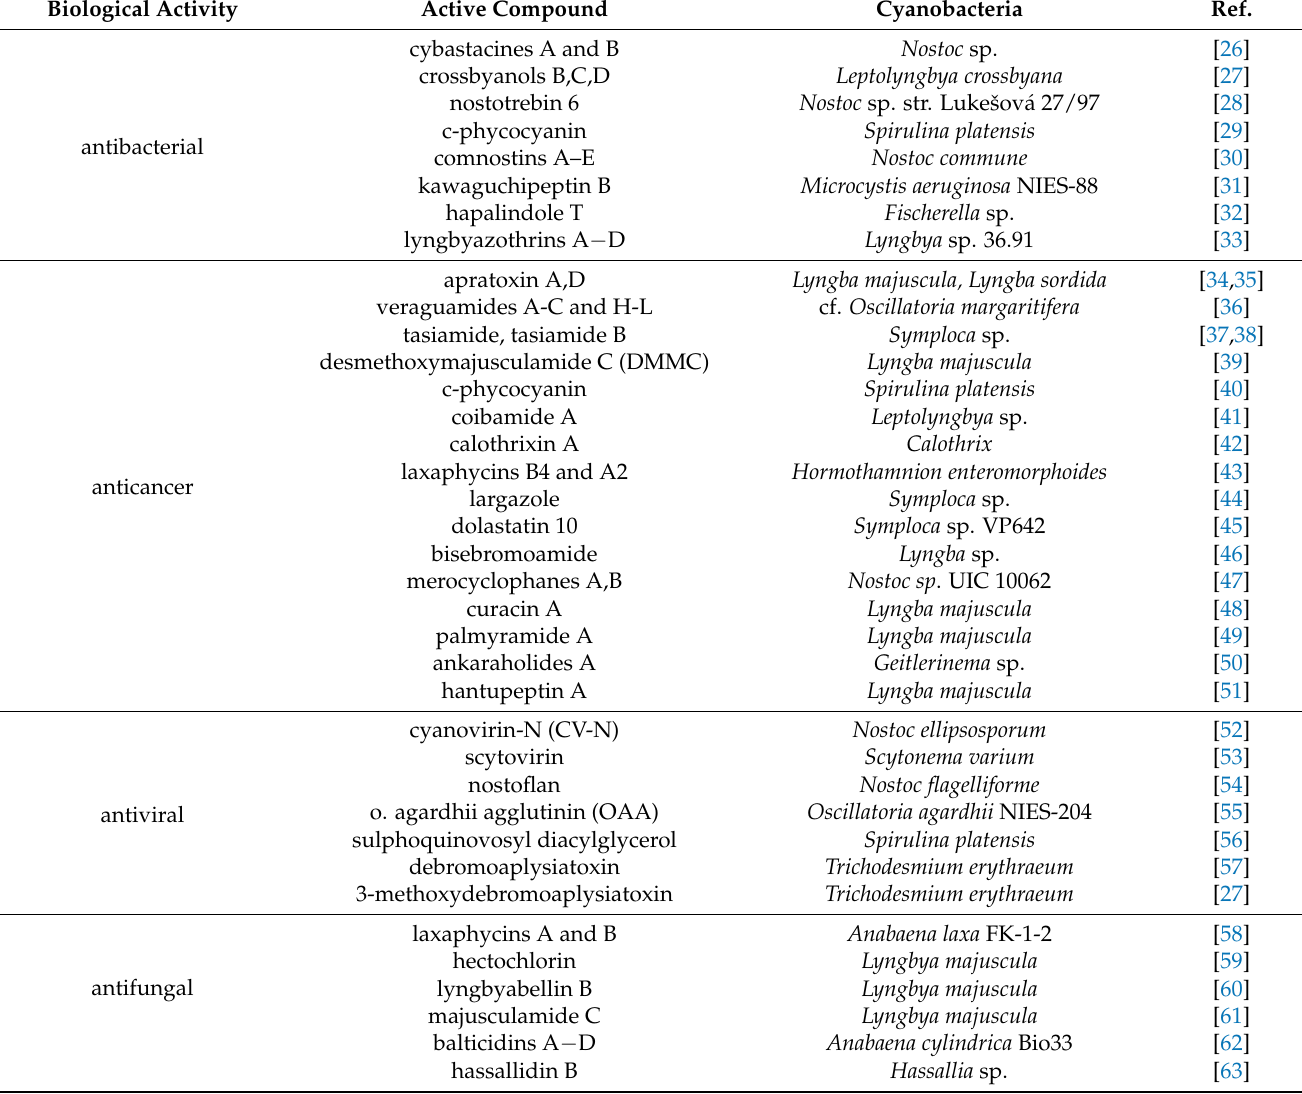
Table 1. Selected biologically active compounds derived from